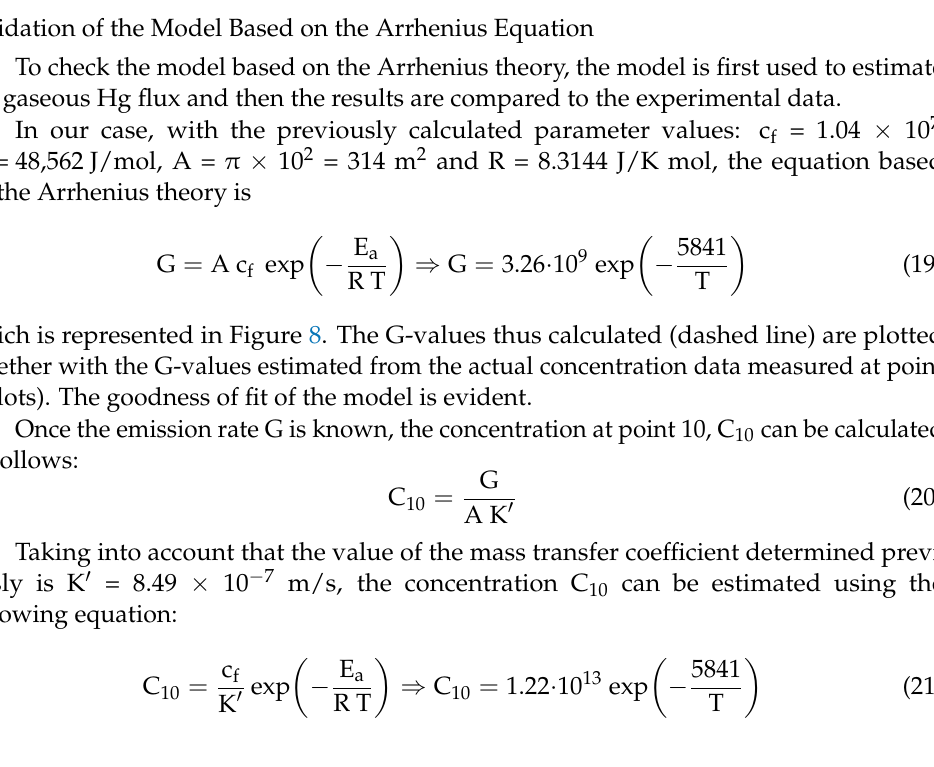
Figure 8. Emission Rate vs. temperature values derived from measurements (dots) and calculated with model based on Arrhenius theory (line).